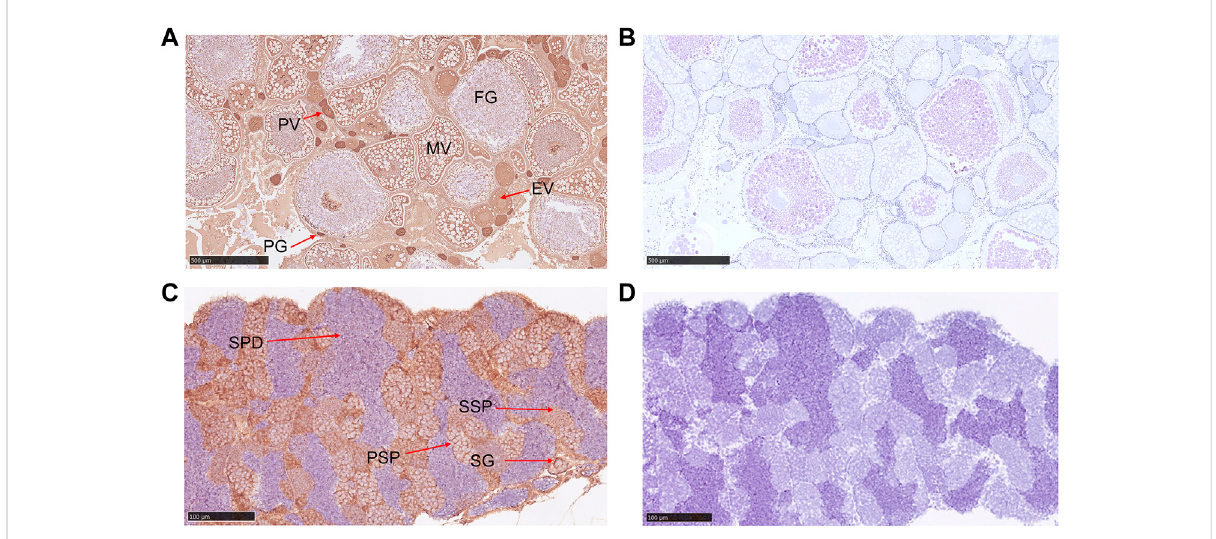
FIGURE 4 Immunohistochemical analysis of G α q in ovary and testis. (A) Immunohistochemical analysis of G α q protein in the ovary. PG: primary growth stage; PV:previtellogenicstage;EV: earlyvitellogenicstage;MV:midvitellogenicstage; FG:fullgrown stage;scalebar:500 μ m; (B) negativecontrol; scale bar: 500 μ m. (C) Immunohistochemical analysis of G α q protein in the testis. SP: spermatogonia; PSP: primary spermatocyte; SSP: secondary spermatocyte; SPD: spermatids; scale bar: 100 μ m. (D) Negative control; scale bar: 100 μ m.